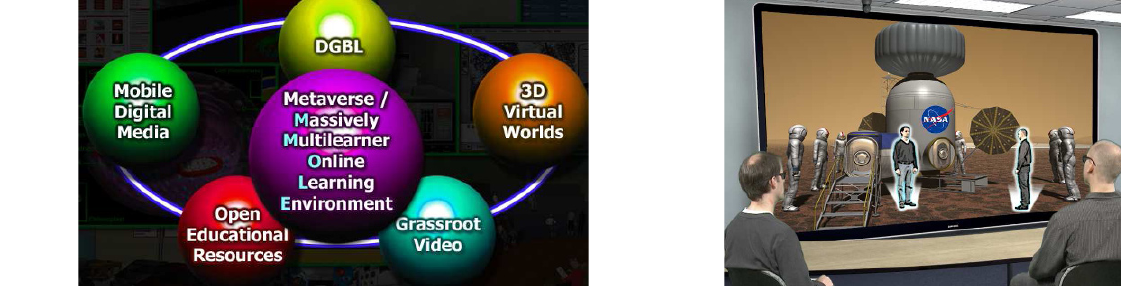
Figure 10. Massively Multilearner Online Learning Environments (MMOLE) concept.